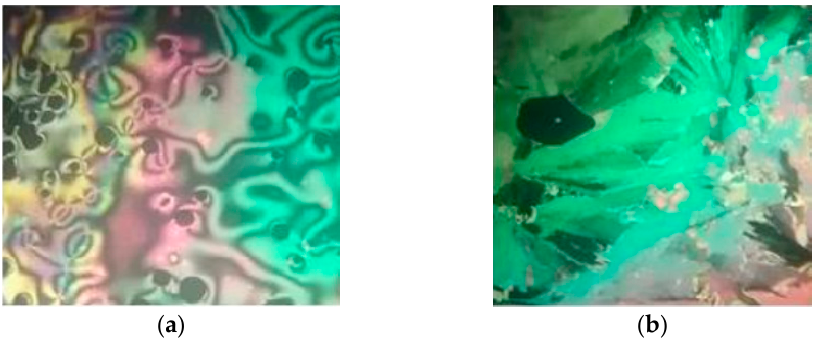
Figure 7. The optical photomicrograph of ( a ) nematic phase of compound 5b at 99.0 ◦ C upon cooling; ( b ) Smectic A phase of compound 5f at 106.0 ◦ C. Reprinted/adapted with permission from Ref. [28]; published by Elsevier,